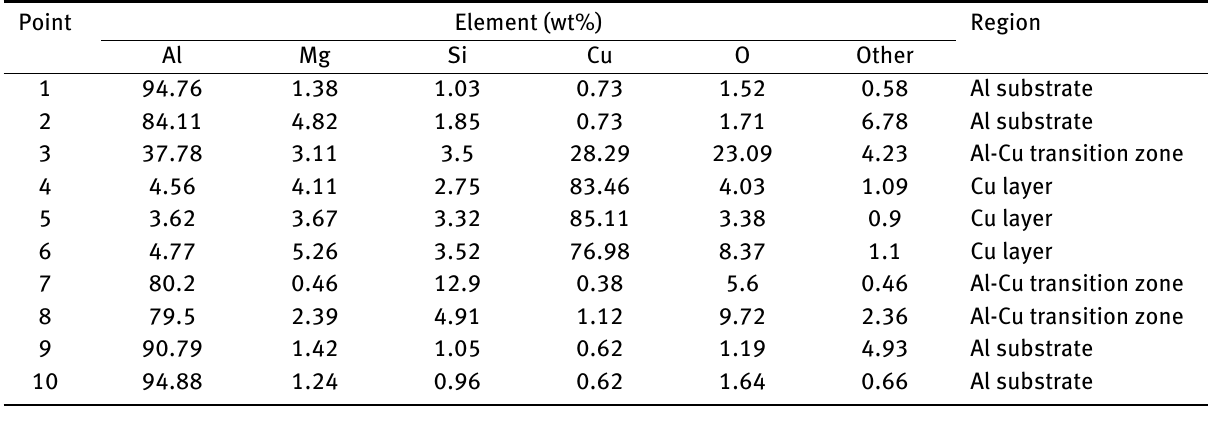
Table 5: Chemical spot analysis result at the interface of W15 P-FSSW joints